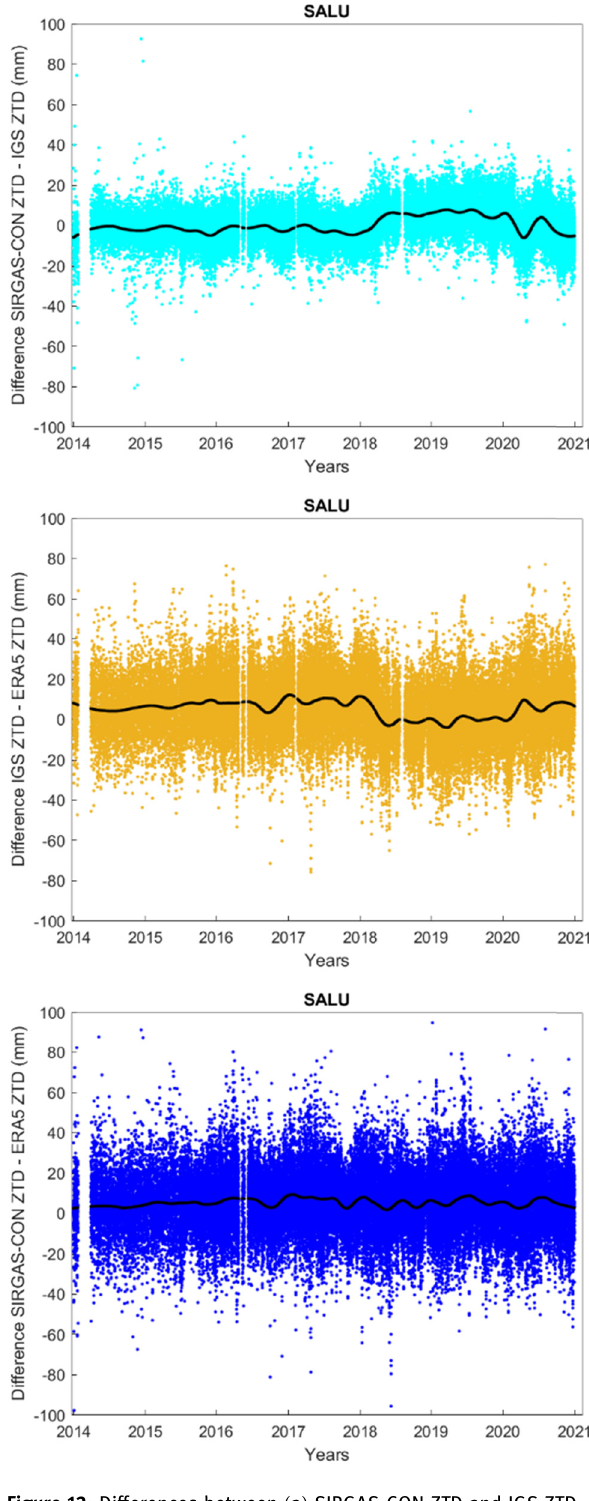
Figure 12: Di ff erences between ( a ) SIRGAS - CON ZTD and IGS ZTD; ( b ) IGS ZTD and ERA5 ZTD; and ( c ) SIRGAS - CON ZTD and ERA5 ZTD for station SALU.